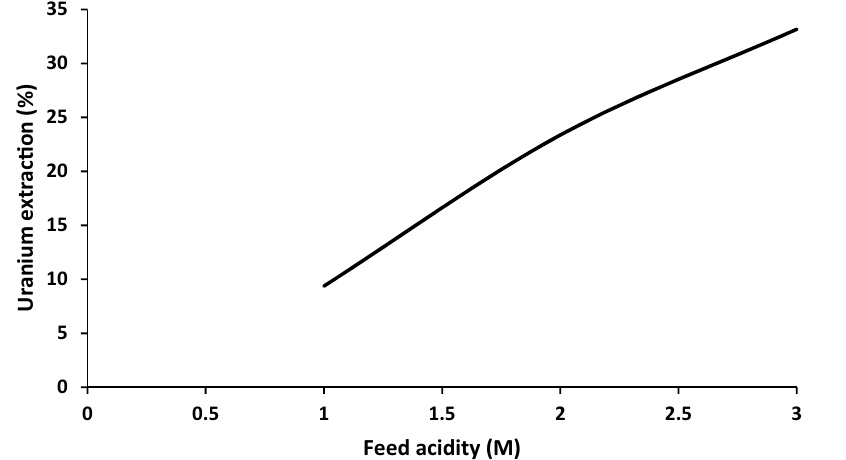
Figure 9. Change in uranium extraction as a function of feed acidity.